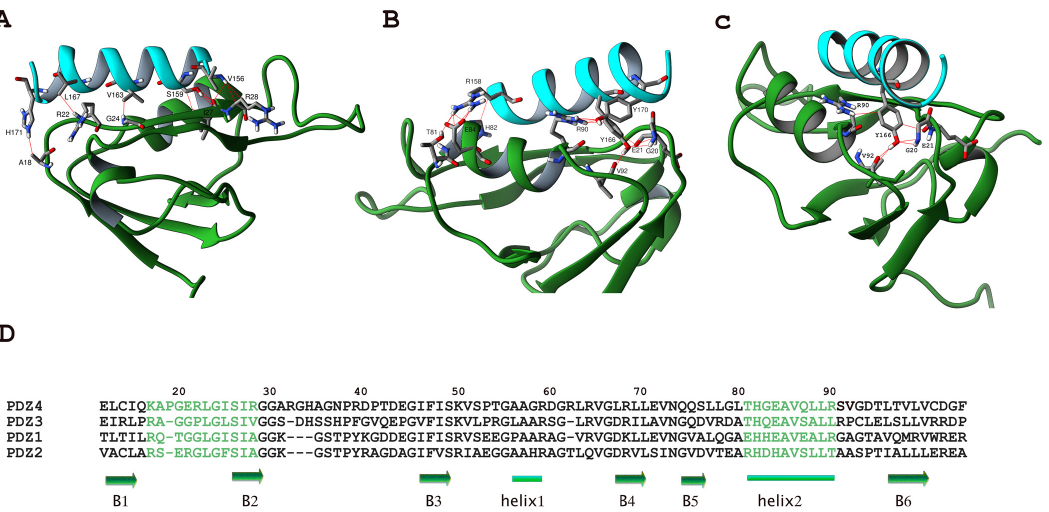
Figure 3. Ribbon diagrams of Dusp26–Scribble PDZ-4 structural models best ranked in HADDOCK analysis visualized with UCSF Chimera [29]. (A–C) Different orientations of the model are shown to highlight potential binding residues. Dusp26 peptide SRSATLVLAYLMLYHHL is colored in blue, while Scrib-4 is colored in green. Potential hydrogen bonds between atoms of the two proteins are indicated. (D) Multiple alignment of the four PDZ domains of Scribble according to Clustal Omega [31]. β strands are indicated with a green arrow and α helices are with a green bar. Residues that form the binding pocket for the ligand are colored in green. For clarity, the residues numbers refer to the crystal structure PDB 1UJU.